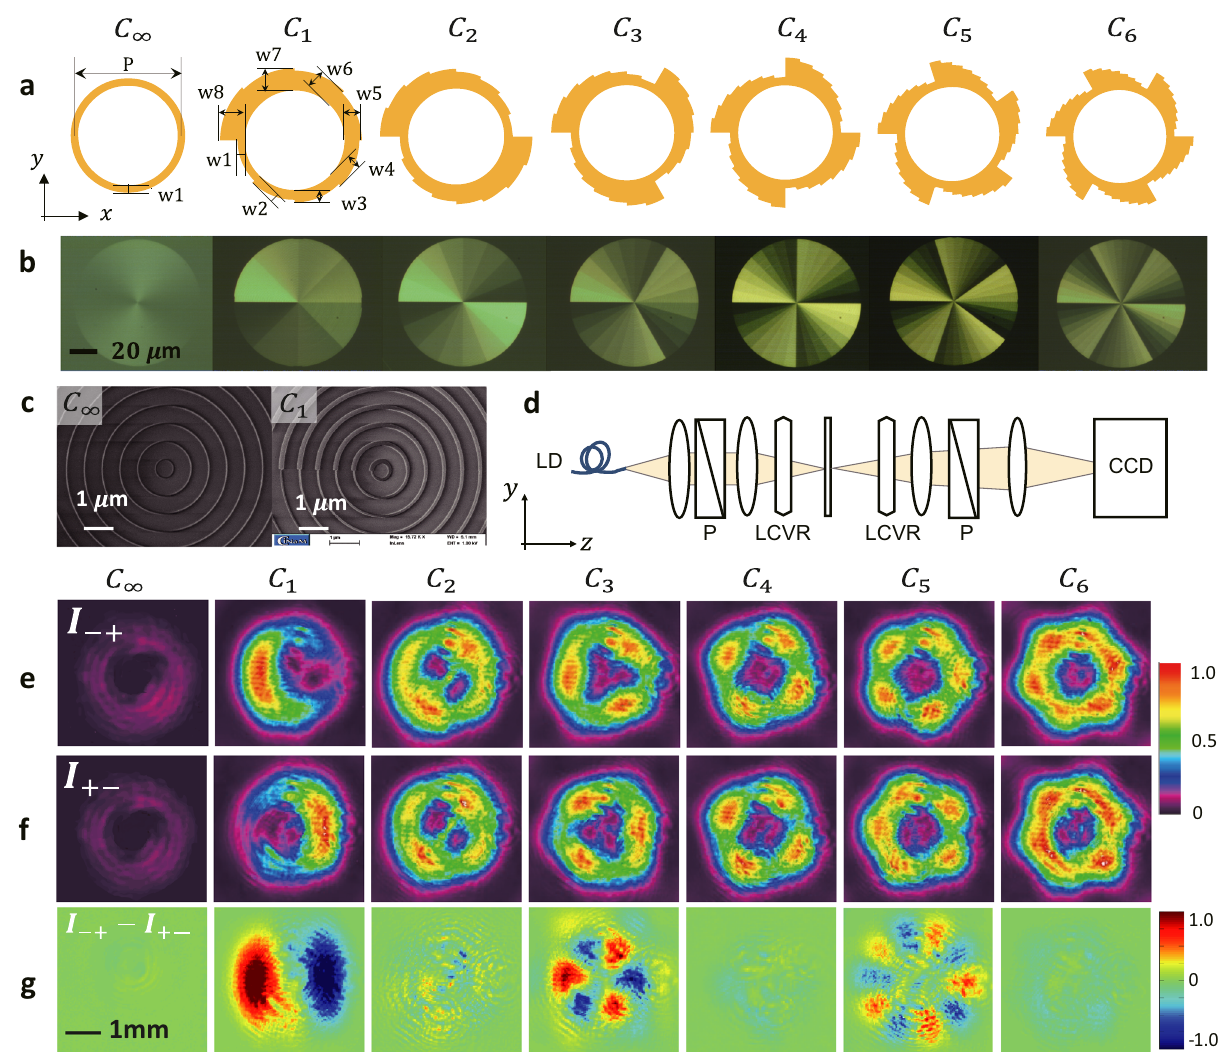
Figure 3: Cyclic group symmetric metasurfaces and a spin- dependent beam separation. (a) Designed TA-CGSM belonging to cyclic groups of C ∞ h , C 1 h , C 2 h , C 3 h , C 4 h , C 5 h , and C 6 h , respectively. Periodicity is denoted by p (cid:2) 600 nm, and widths of arcs are by w 1 (cid:2) 45 nm, w 2 (cid:2) 60